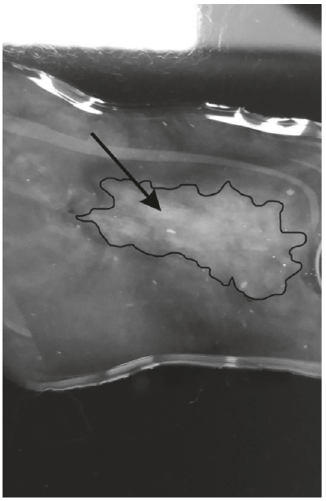
Figure 2: In vitro on the glass slide clear vancomycin at the concentration of 1 mg/0.1 mL was instilled in a clear Aurovisc (cid:2) (black outline). Note opacification (black